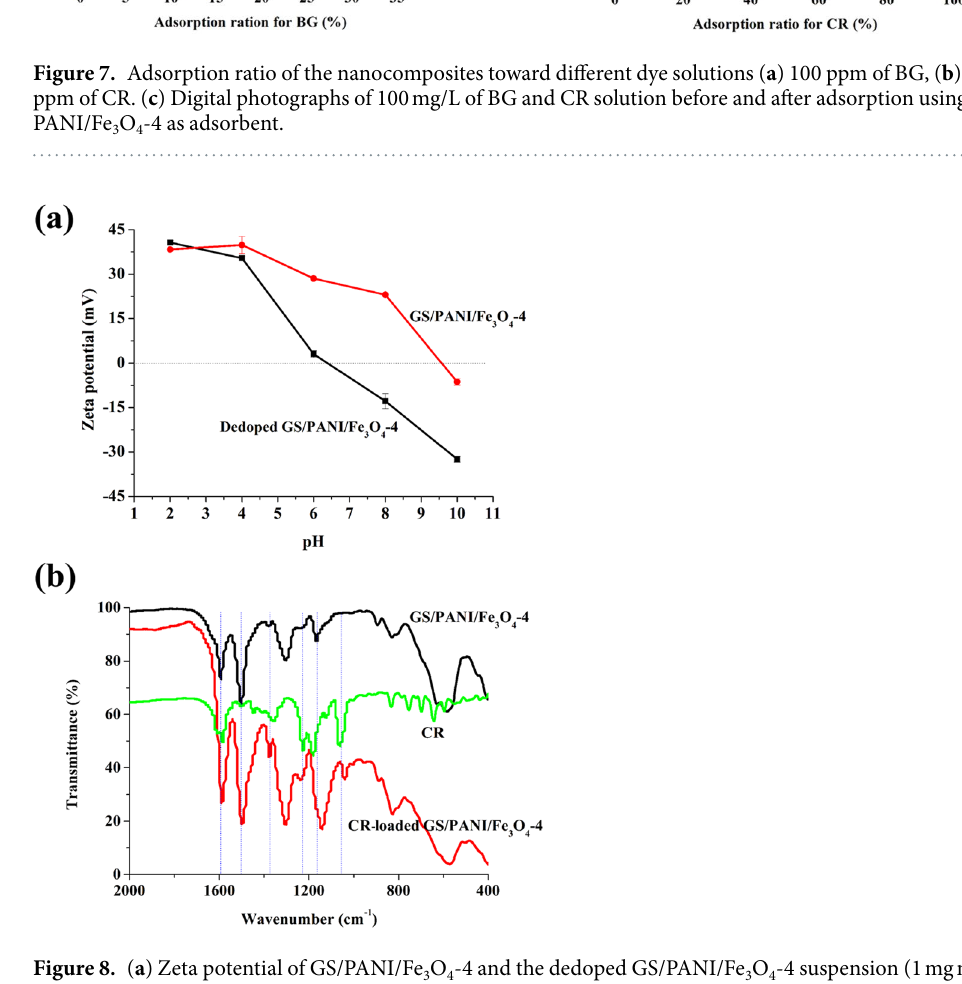
Figure 8. ( a ) Zeta potential of GS/PANI/Fe 3 O 4 -4 and the dedoped GS/PANI/Fe 3 O 4 -4 suspension (1 mg mL − 1 ) at different pH values (The measurement was repeated three times under the same conditions). ( b ) FTIR spectra of GS/PANI/Fe 3 O 4 -4, CR and CR-loaded GS/PANI/Fe 3 O 4